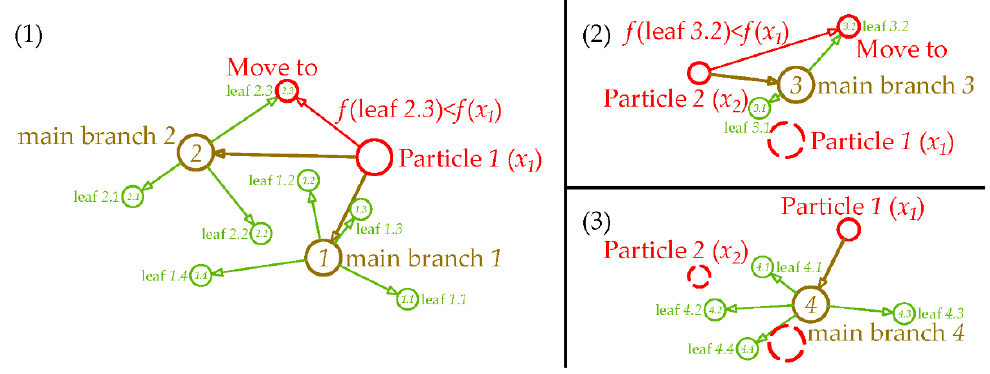
Figure 3. Graphical representation of the new local search method.